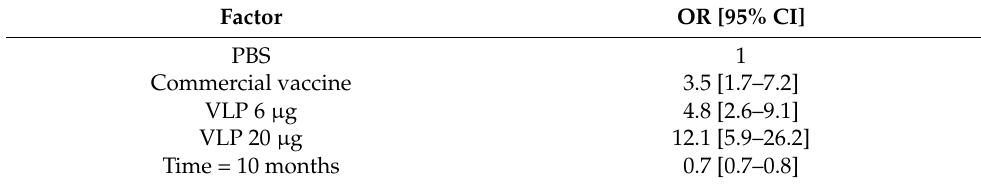
Figure 7. Kaplan–Mayer survival curve of the three experimental challenges with intramuscular injection of RGNNV. Table 2. Odds ratio (OR) of survival in Study